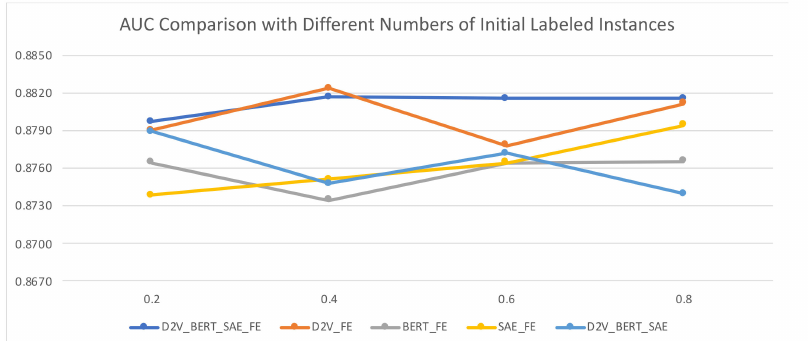
Figure 8. AUC comparison with different numbers of initial labeled